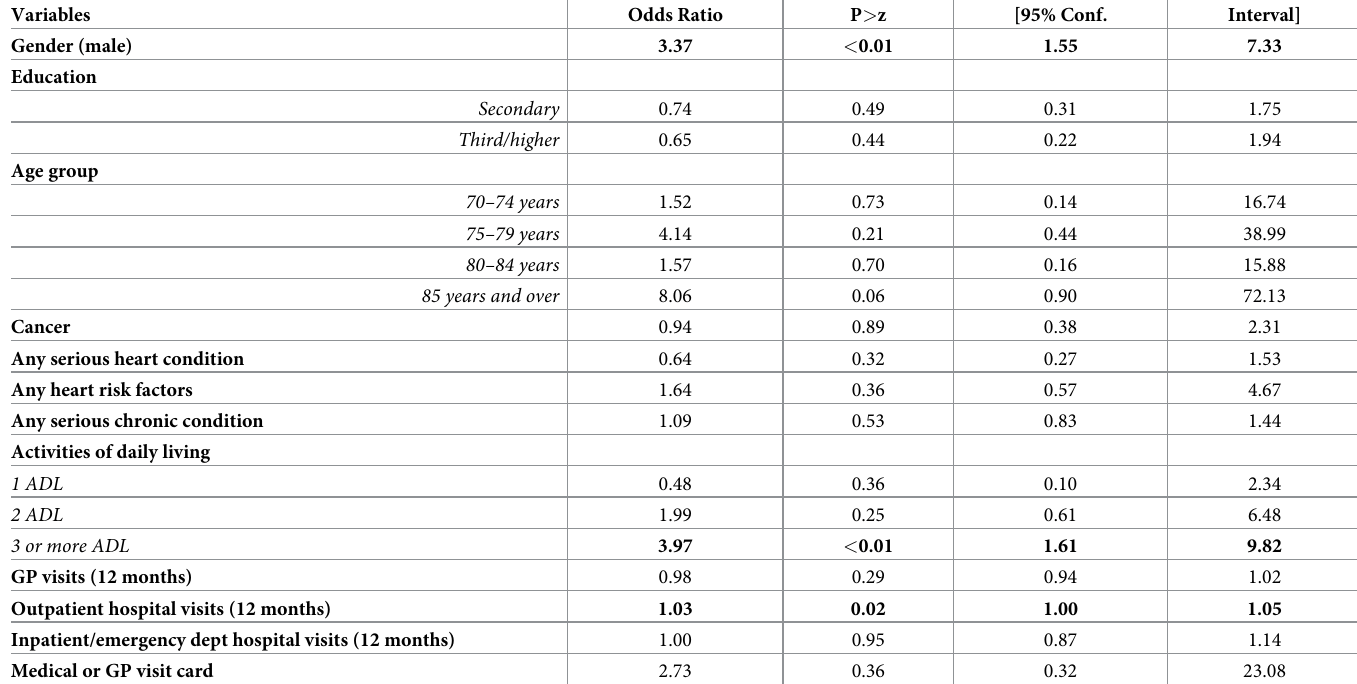
Table 4. Multivariable regression results for potentially questionable